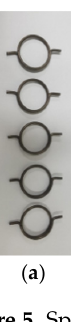
( b ) Figure 5. Springs and experiment setup: ( a ) torsion springs; ( b ) experiment setup.